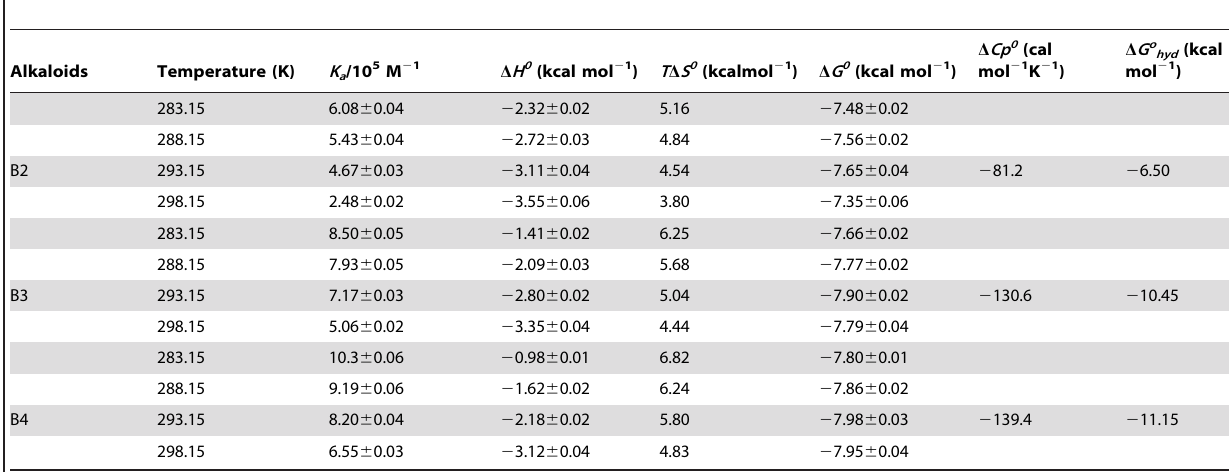
Table 4. Thermodynamic parameters for the association of alkaloids with tRNA from ITC at different temperatures a .